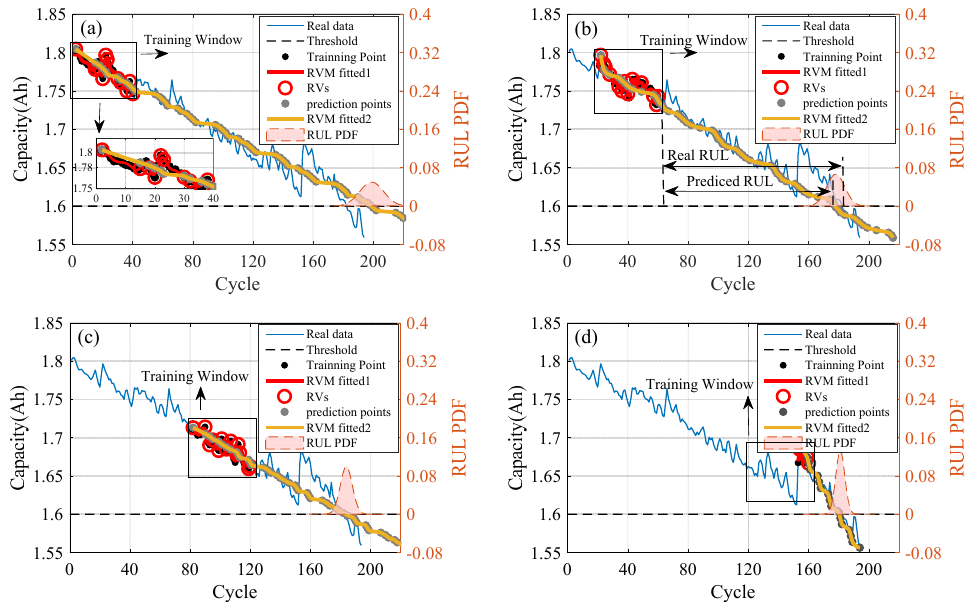
Figure 2. RUL prediction result of No. 36 with a fixed window size 40: ( a ) inspected cycle of 40; ( b ) inspected cycle of 72; ( c ) inspected cycle of 122; ( d ) inspected cycle of 162. The red circles in the training window are the relevance vectors trained by RVM. These vectors are then used for grey prediction and function interpolation, and the prediction trend curve can be fitted as displayed by the yellow lines in Figure 2; therefore, the degradation threshold and probability distribution can be obtained by training